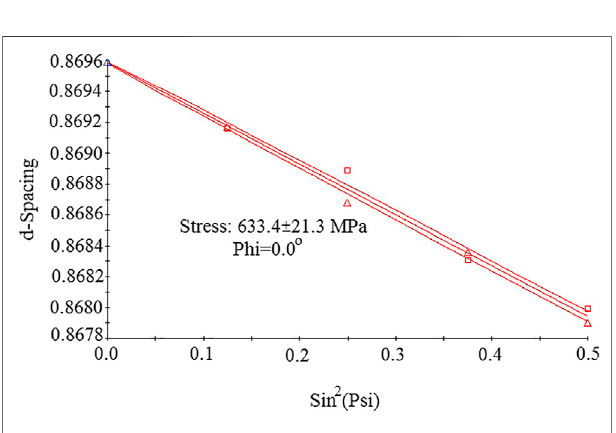
FIGURE 7 | d – sin2 ψ diagram for sample c3.